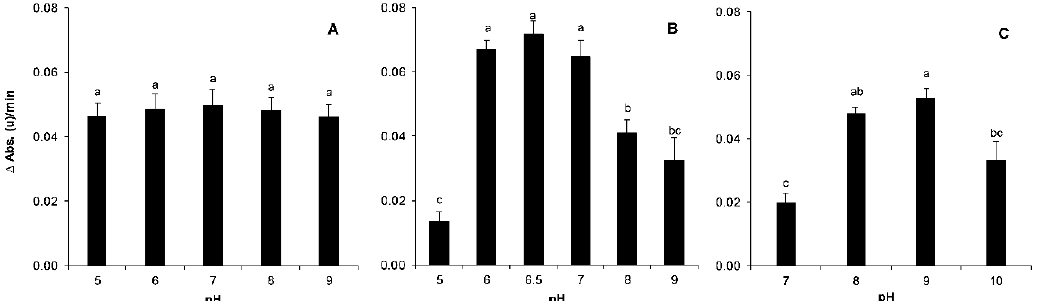
Figure 4. Influence of pH on reaction rates ( ∆ Abs.(u)/min) with the three respective substrates ( α -naphthyl acetate ( A ), CDNB ( B ) and cytochrome C ( C )). The error bars correspond to standard error (total number of insects tested, ( A ) n = 65, ( B ): n = 75, ( C ): n = 12). Vertical bars with different letters are significantly different according to mean separation using Tukey–Kramer’s test ( p < 0.05).